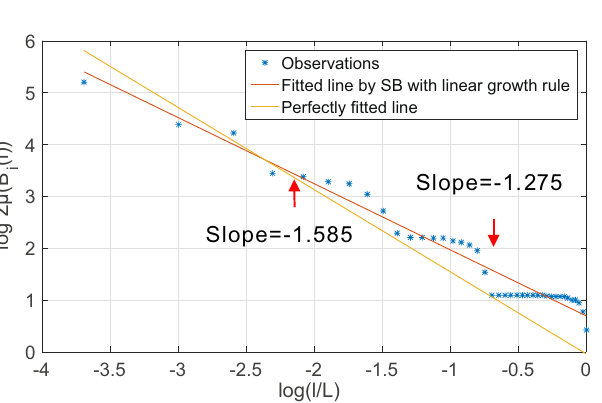
Figure 4. Observation of staircase effect in determination of dominant fractal dimension of G 4 of Sierpinski fractal network family using sandbox method with an incompatible linear growth